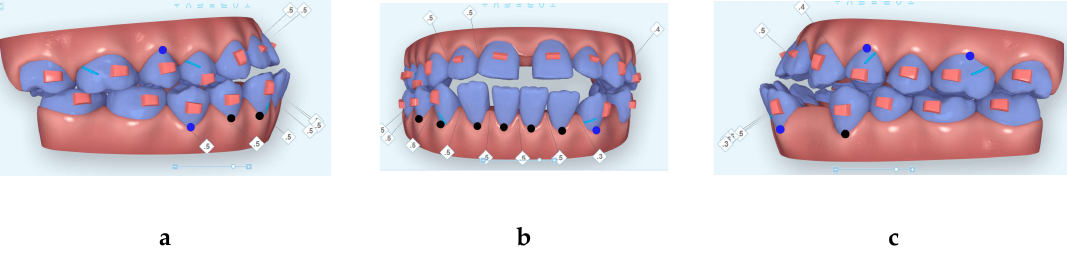
Figure 4. Images of the beginning of first Clincheck ( a ): right side; ( b ) frontal view and ( c ) left side .